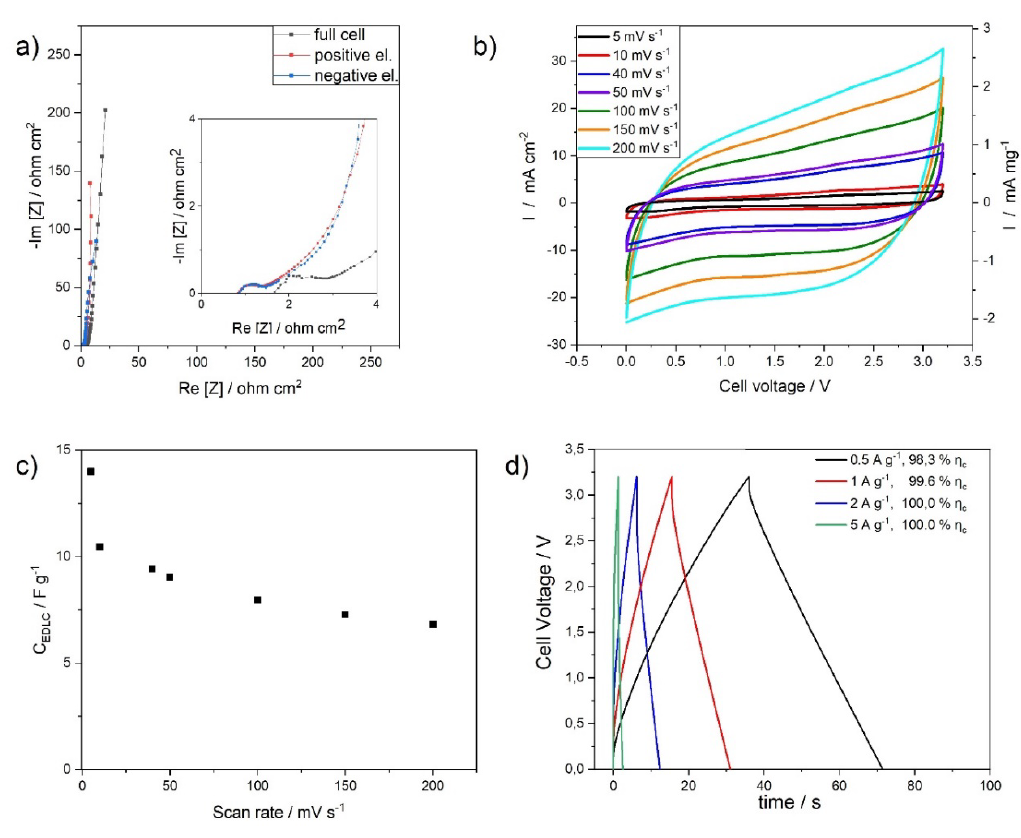
Figure 5. Electrochemical characterization of LBHME-EDLC ( a ) Nyquist plots of the (black) full cell, (red) positive and (blue) negative electrodes (500 kHz and 100 mHz), ( b ) 2-electrode CVs at different scan rate from 5 mV s -1 to 200 mV s -1 , between 0 V and 3.2 V, ( c ) Capacitance of the EDLC evaluated by CV reported as function of the scan rate; and ( d ) selected galvanostatic charge/discharge cycles between 0 V and 3.2 V at different current densities from 0.5 A g -1 to 5 A g -1 .